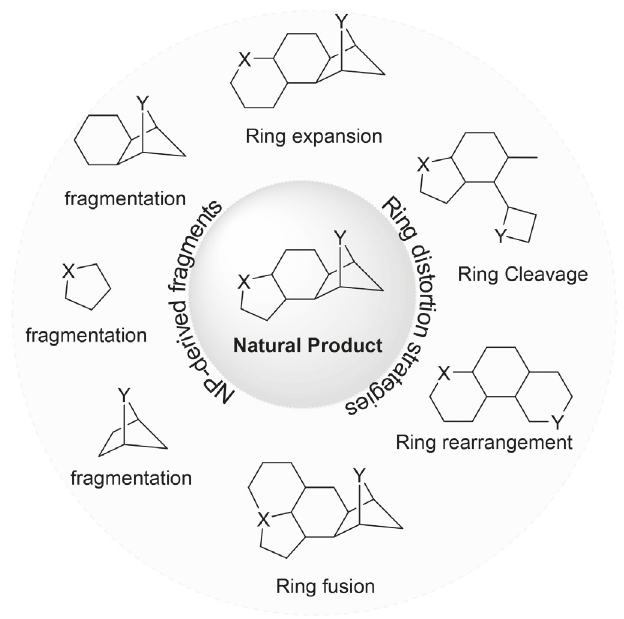
FIGURE 2 - Approaches providing novel opportunities to synthesize natural product-inspired compound